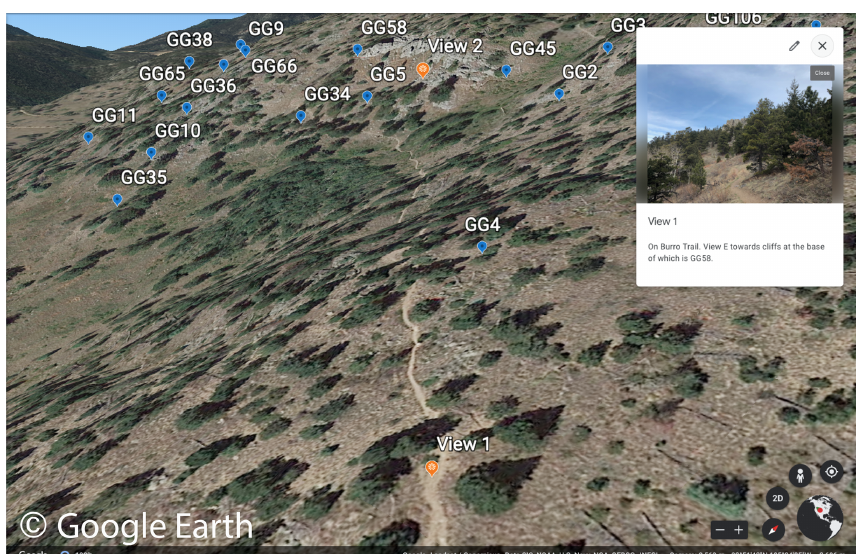
Figure 3. View of the field area from one of the vantage points provided in the Google Earth Web project.